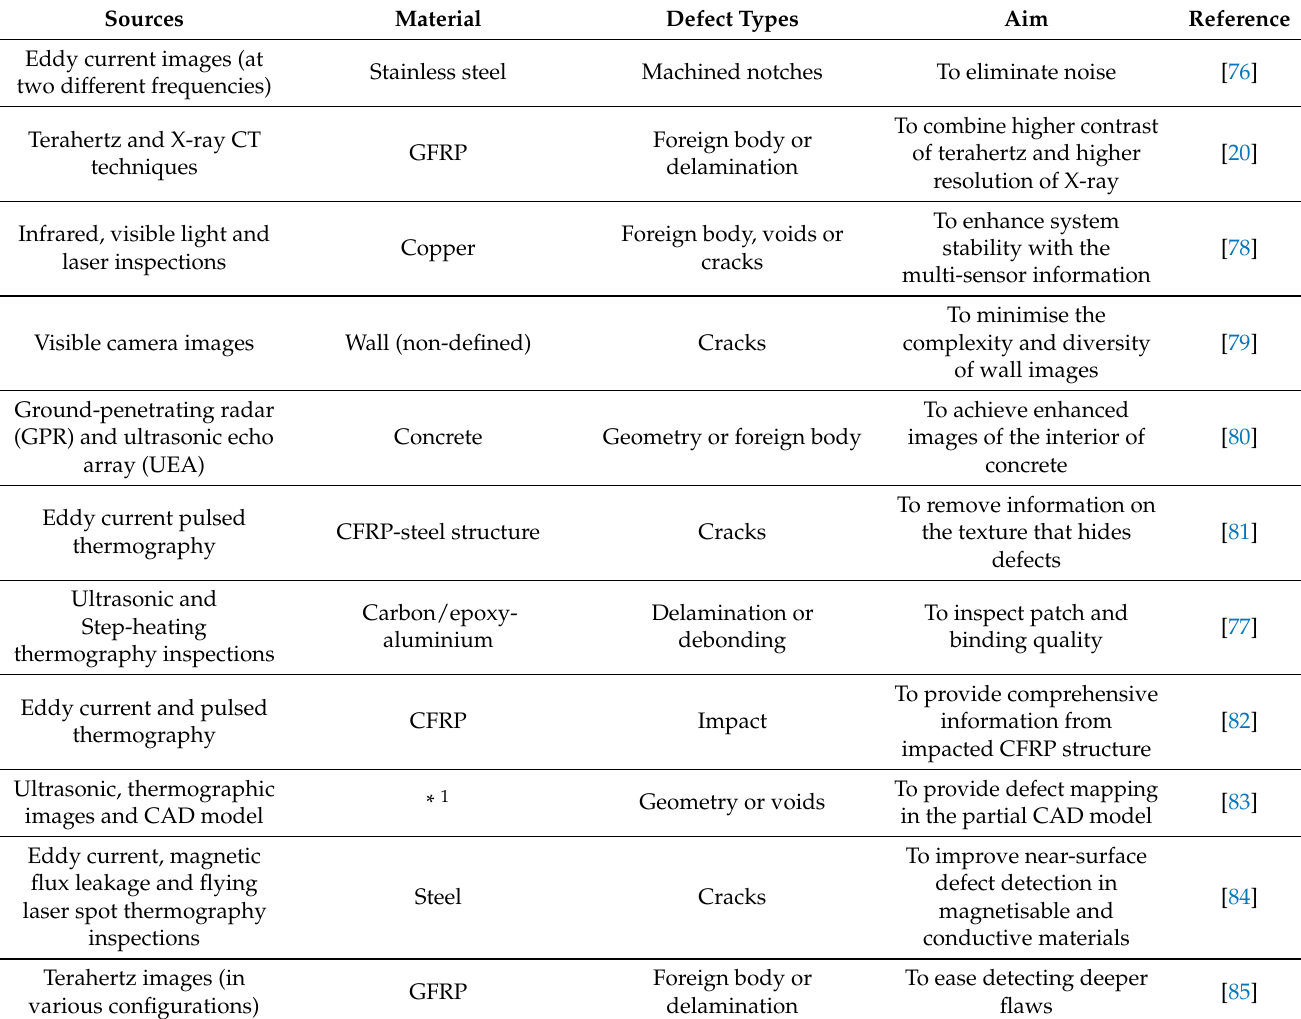
Table 5. A summary of the current wavelet applications for NDT image